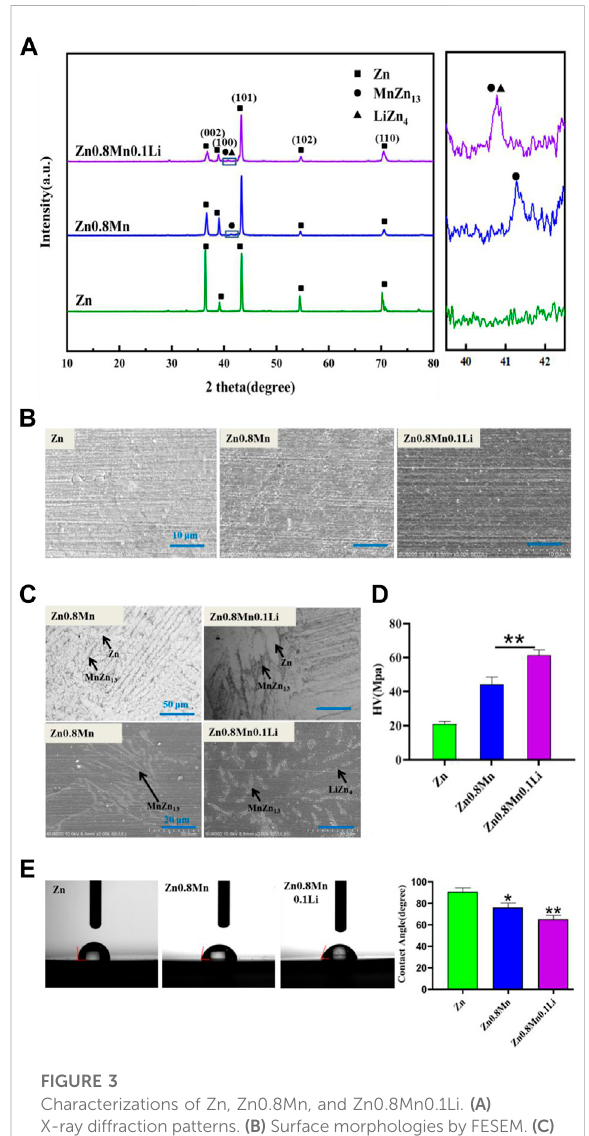
FIGURE 3 Characterizations of Zn, Zn0.8Mn, and Zn0.8Mn0.1Li. (A) X-ray diffraction patterns. (B) Surface morphologies by FESEM. (C) The metallographic structure. (D) Microhardness. (E) Water contact angles.* p < 0.05 compared to pure Zn, ** p < 0.01 compared to pure